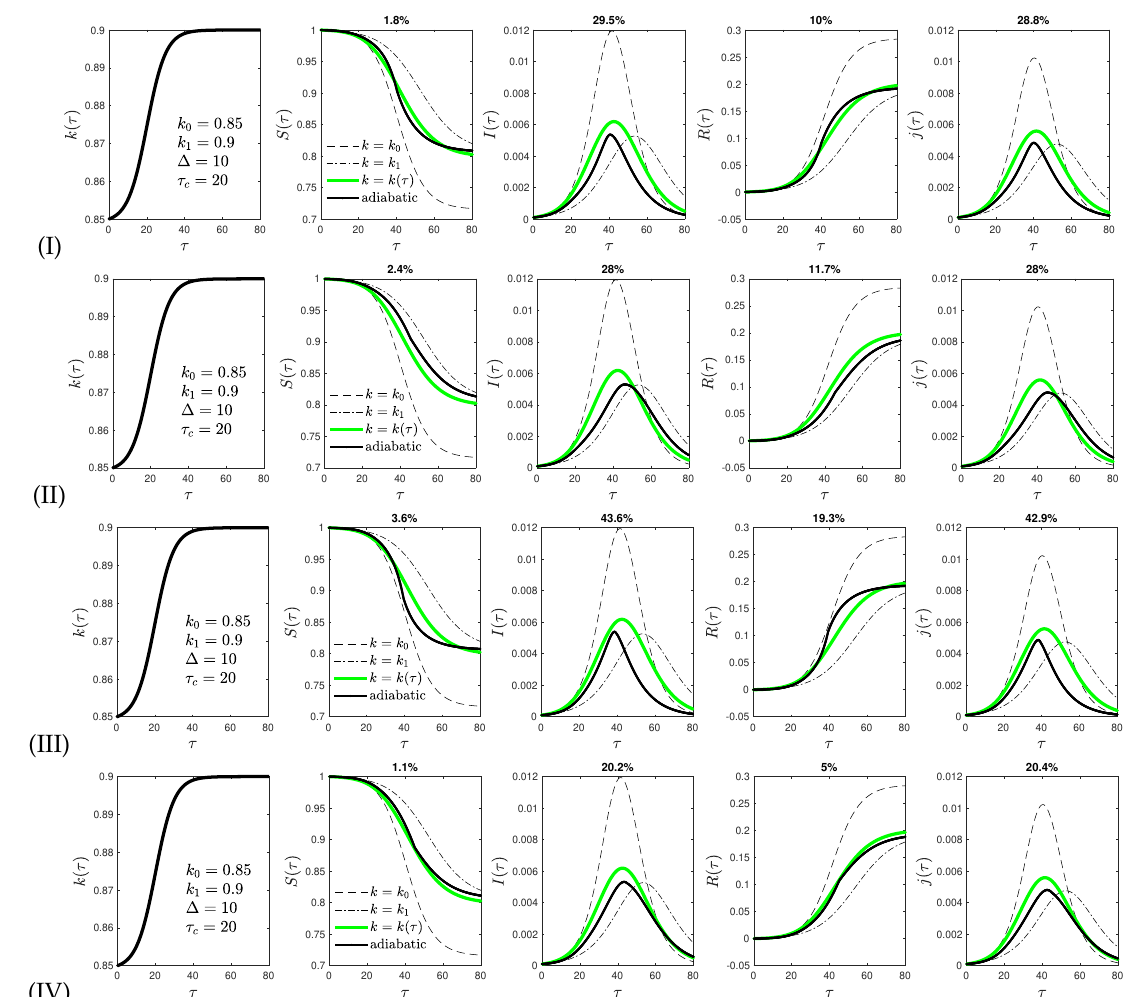
Figure 3. Same as Figure 2 but with another set of the parameters ( k 0 = 0.85, k 1 = 0.9, ∆ = 10, and τ c = 20) of the ratio k ( τ )